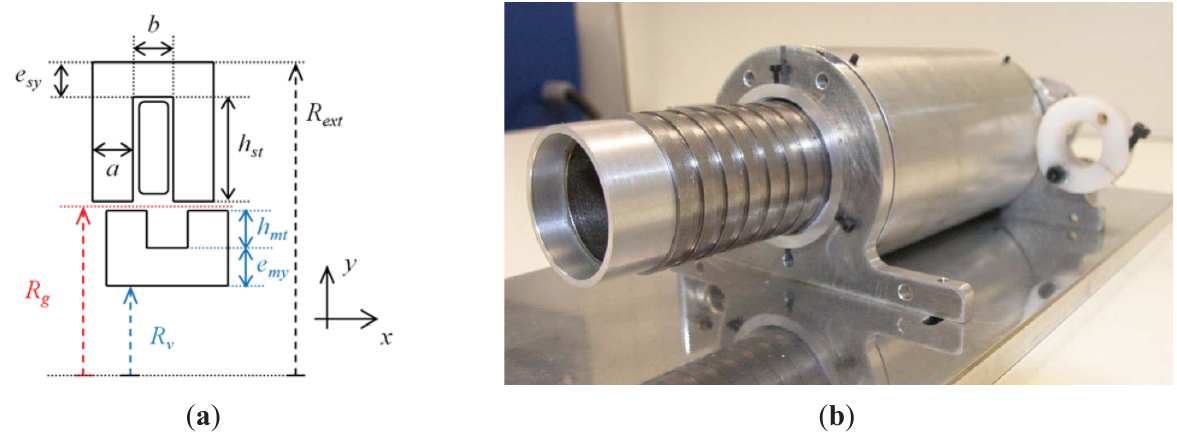
Figure 2. ( a ) Basic pattern; ( b ) Picture of Pulsamag